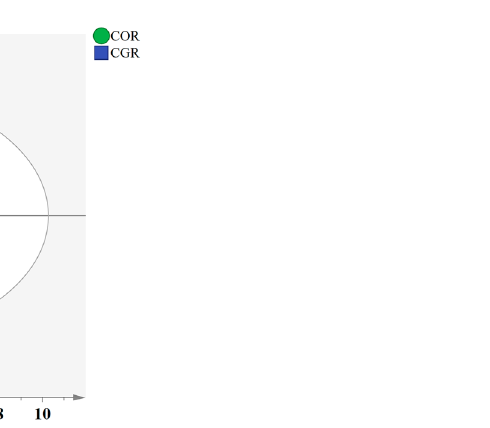
Figure 5. PCA classification result. Scatter plots of COR and CGR samples ( a ), PCA biplot for component PC1 and PC2 ( b ).